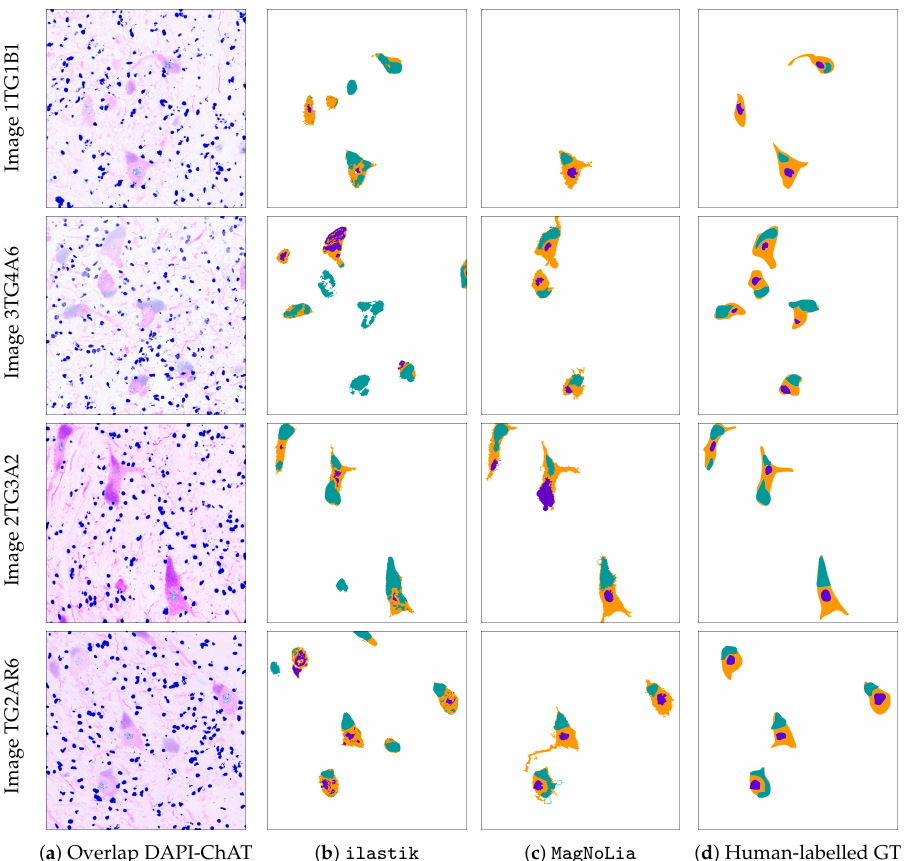
Figure 7. Visual representation of the output by ilastik , MagNoLia and human experts for four different images in the dataset. Each row contains the results for a single image. Column ( a ) displays an overlap of the DAPI (coloured in blue) and ChAT (coloured in magenta) channels; Columns ( b – d ) display the output by ilastik , MagNoLia and the human labeller, respectively. In Columns ( b – d ), teal pixels represent inclusions, orange ones represent cytoplasms and purple ones represent